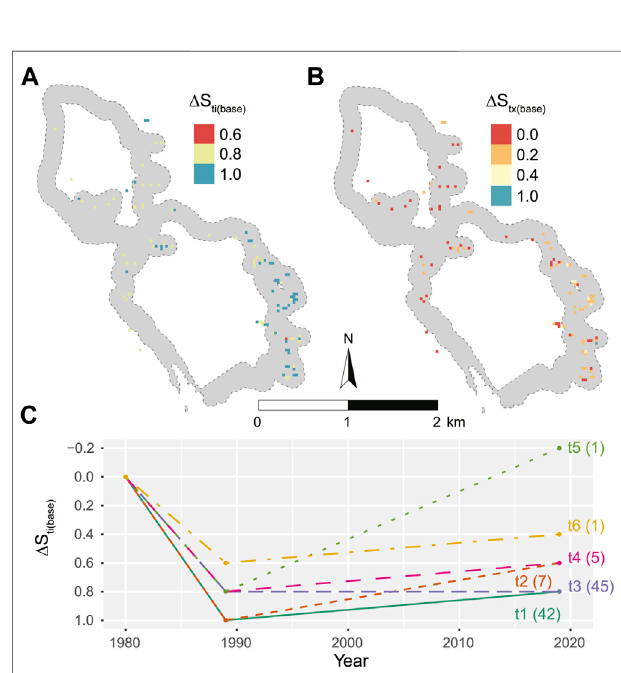
FIGURE 7 | (A) baseline normalized impact and (B) post-disturbance recovery on a 30 m grid within the area surveyed (grey) based on a system identity of fi ve dracaena individuals pr 30 m grid cell. In total 101 cells had Tombat individuals in 2019. In (A) cells with 100% impact ( Δ S ti ( base ) = 1) are cells that contained saplings but had no adults. In (B) cells with 0% recovery( Δ S tx ( base ) =0)arecellsthatcontainedadultsbuthadnosaplings (C) Trajectories (T) describing how the system developed from a pre-disturbance state (assumed 1980), until end of disturbance (assumed 1989), and its recoveryuntil2019.Oursystemdeveloped alongsixdifferent trajectories. The baseline normalized impact Δ S ti ( base ) indicates the proportion of Tombat that is lost (i.e., a value of 0 corresponds to system identity). t3 includes cells that experienced 80% impact, i.e., one adult Tombat survived at end of disturbance, and no recovery occurred until 2019 (0%; fl at slope). t1,4 and 6 all experienced recovery of 20% (1 sapling; equal slope). Numbers in parenthesis in the legend refer to number of pixels in each